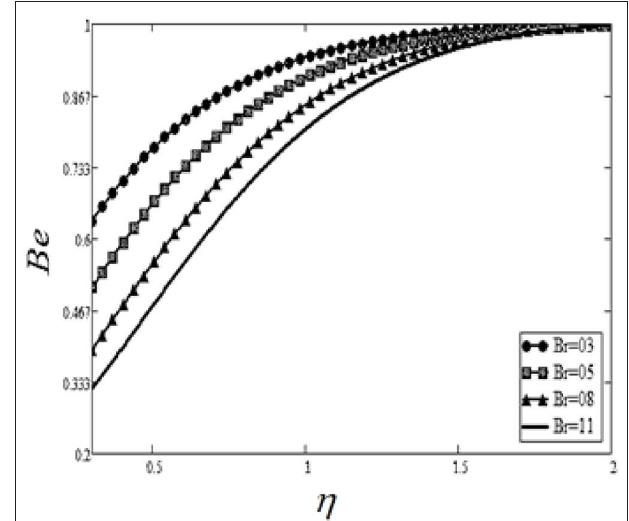
FIGURE 14 | Bejan number plot for Br